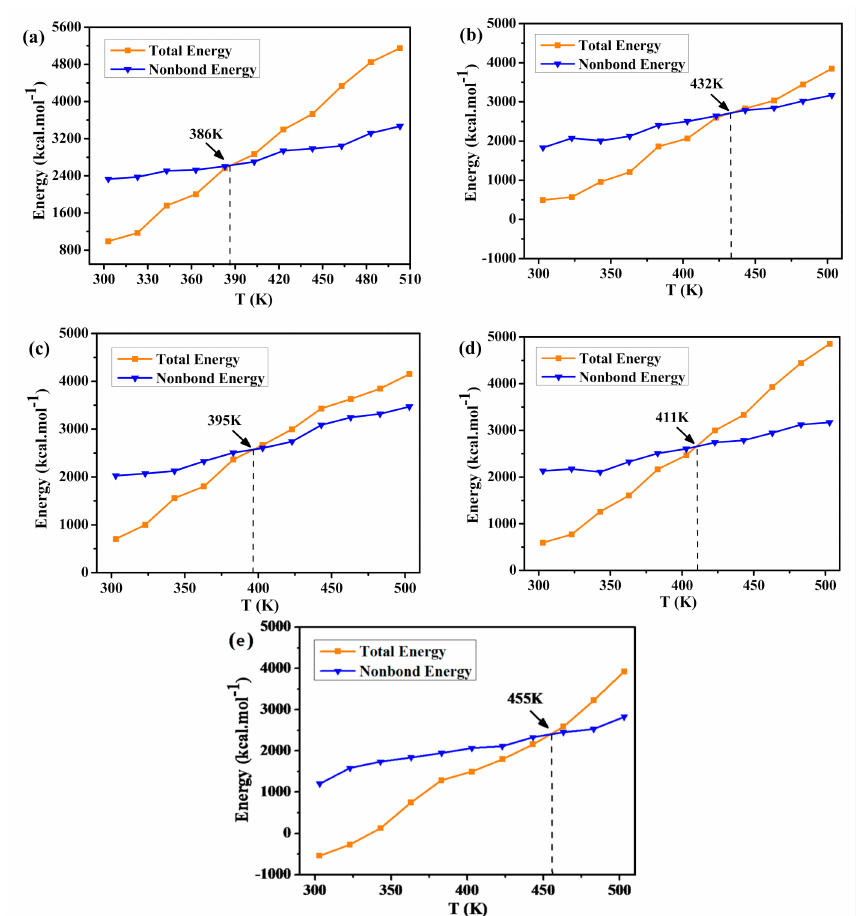
Figure 3. Energies of the models: ( a ) ungrafted model, ( b ) KH550 model, ( c ) KH560 model, ( d ) KH570 model, and ( e ) KH792